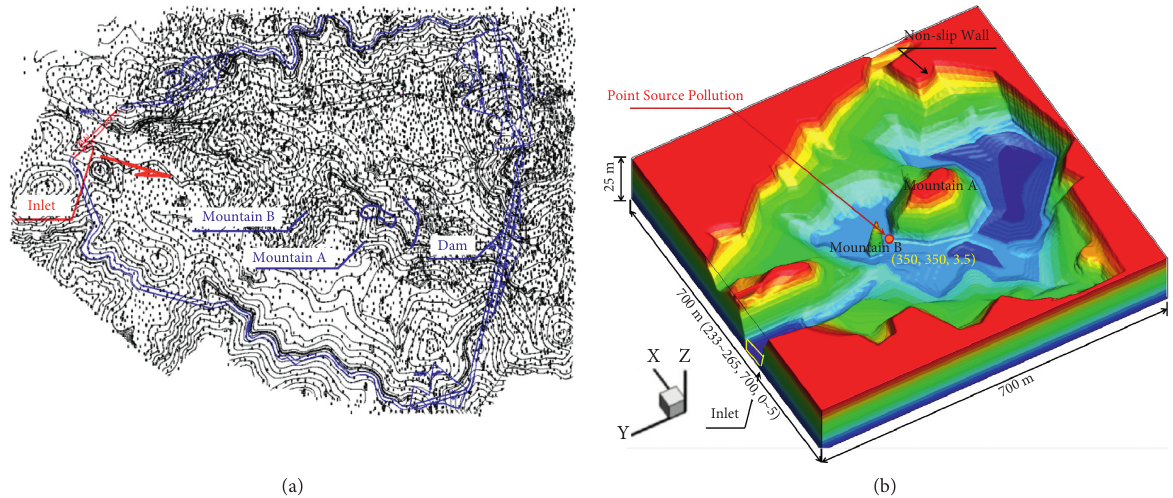
Figure 11: The upper reservoir of a pumped-storage power station: (a) topographic map; (b)